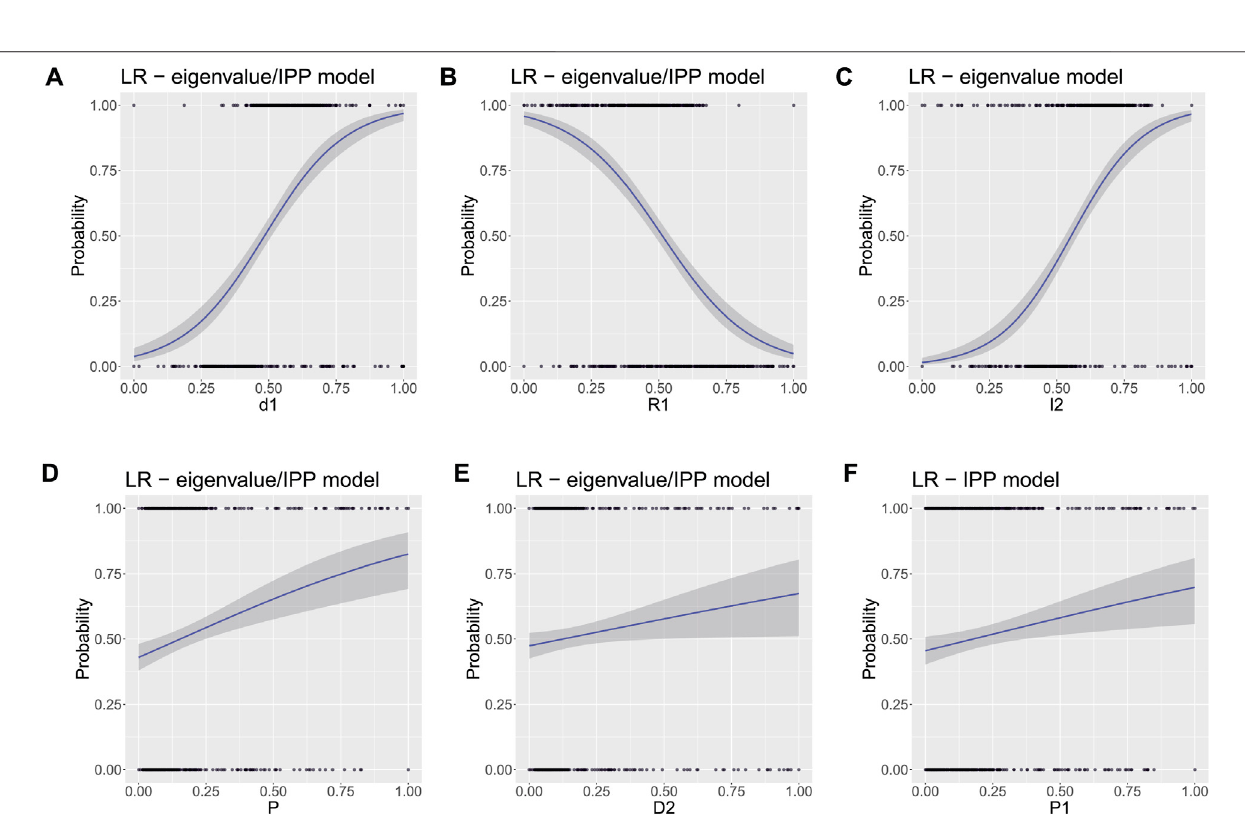
Frontiers in Physics |